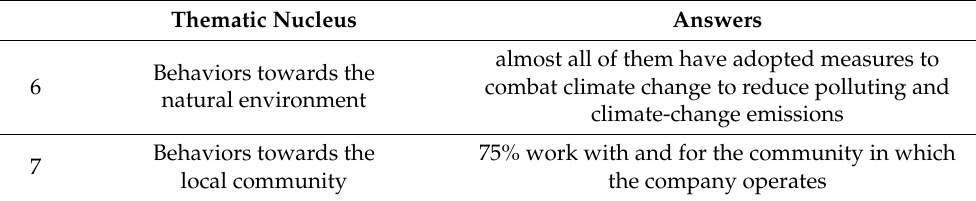
Table 4. Cont. Thematic Nucleus Answers Behaviors towards the 6 natural environment